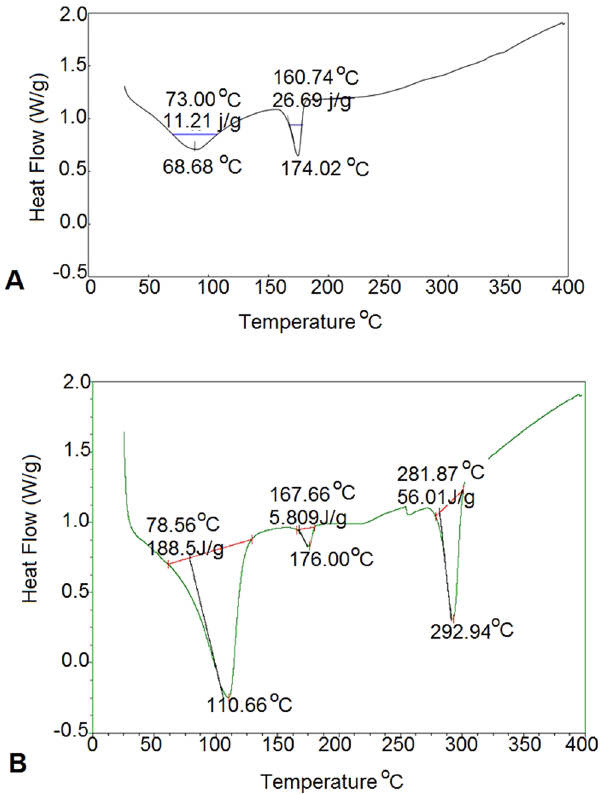
Figure 7. DSC thermograms of melanin ( A ) compared with the DSC of the film prepared using PHB: Nm: Glycerol ( B ). The thermogram showed a highly thermostable peak with a degradation peak at 292.94 °C when compared with the control melanin at 174.02 °C.